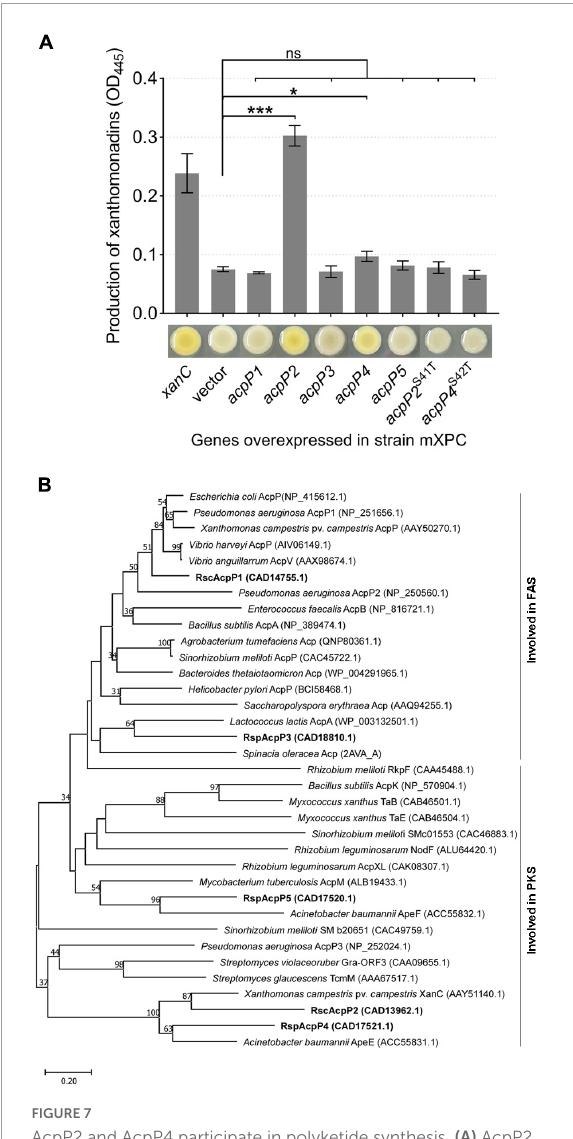
FIGURE7 AcpP2 and AcpP4 participate in polyketide synthesis. (A) AcpP2 and AcpP4 restored the production of xanthomonadin in the X . campestris xanC mutant mXPC. Pigments were extracted with methanol from X . campestris using previously described procedures (Cao et al., 2018). Student’s t -test was used to compare mXPC carrying the empty vector and mXPC overexpressing the acp genes. Significant differences are indicated as *** P < 0.001 and * P < 0.05. (B)